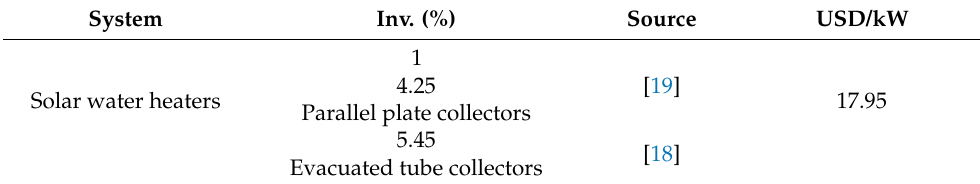
Table 4. Investment costs (DHW production).